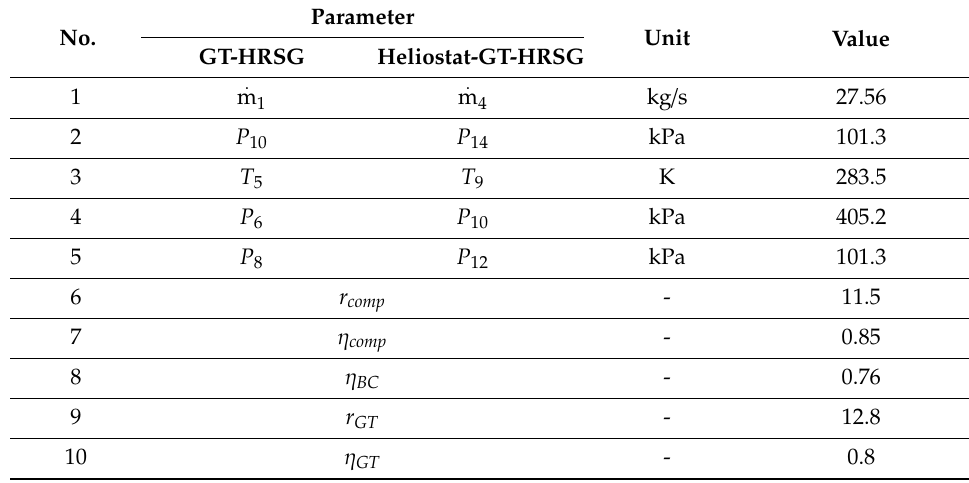
Table 9. The systems’ specification